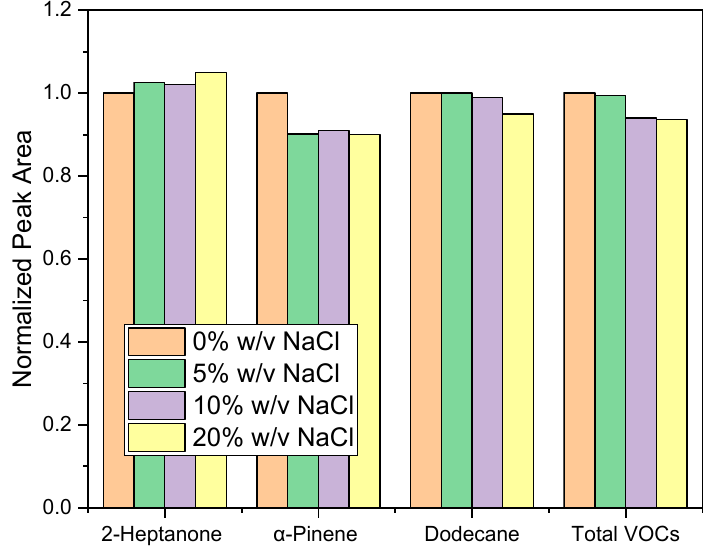
Figure 5. Evaluation of the salt addition for SPME